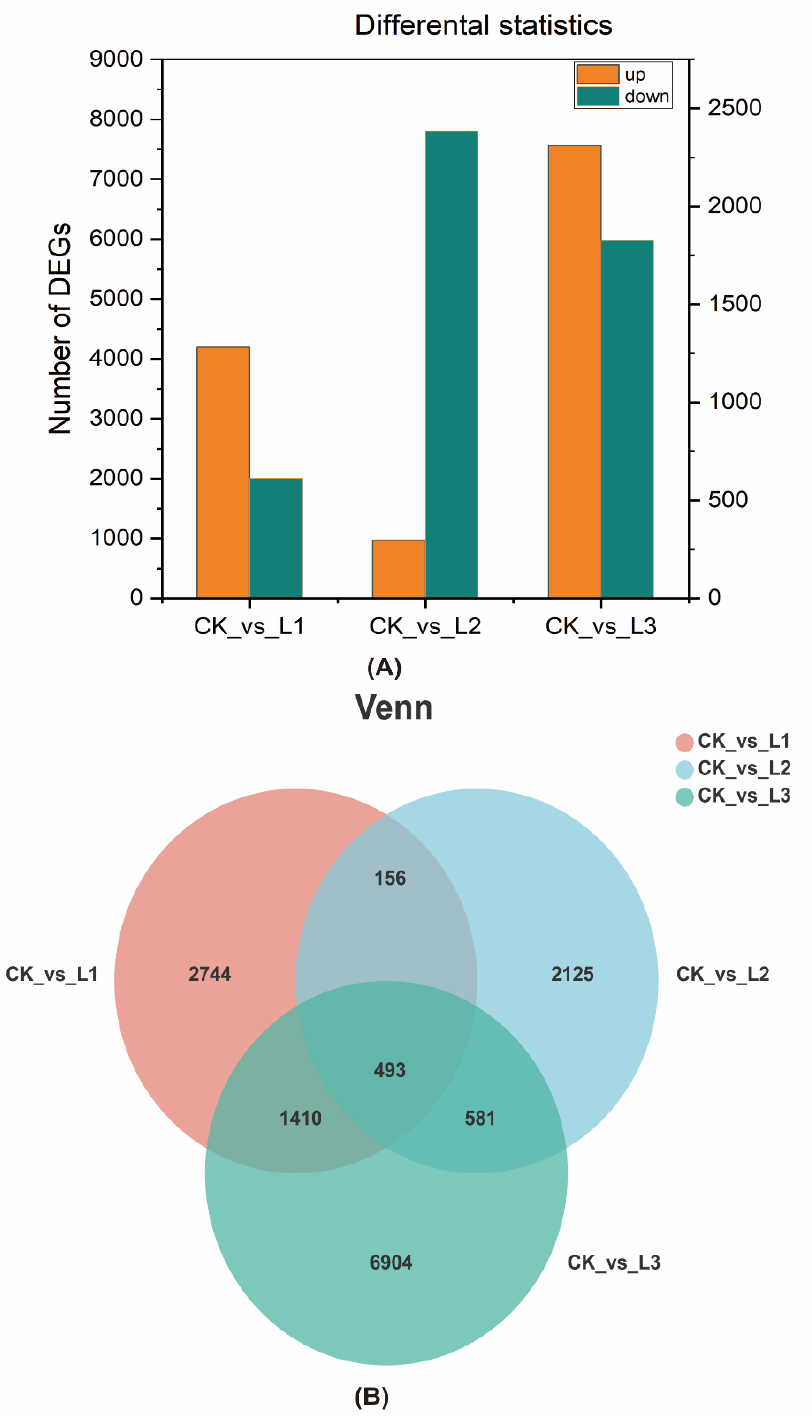
Figure 4. Differentially expressed genes in root tissues of A. dahurica under different light intensities. ( A ) Bar graph of different differentially expressed genes. The left y-axis indicates upregulated genes, and the right y-axis indicates downregulated genes. ( B ) Venn diagram analysis of differentially expressed genes.